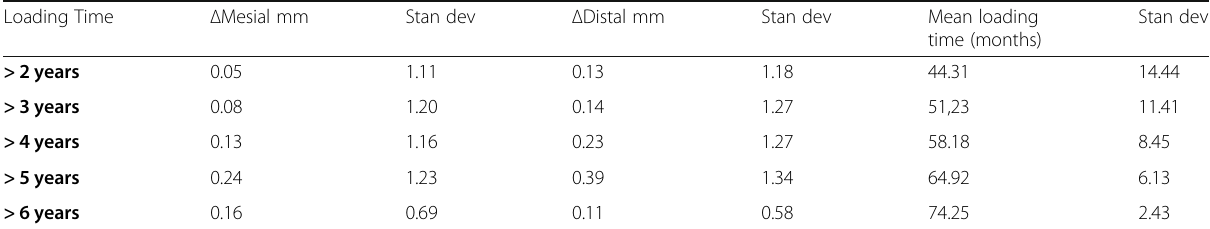
Table 4 Mean peri-implant bone loss/gain between T1 (time of loading) and T2 (last recall) in each year post-functional load Loading Time